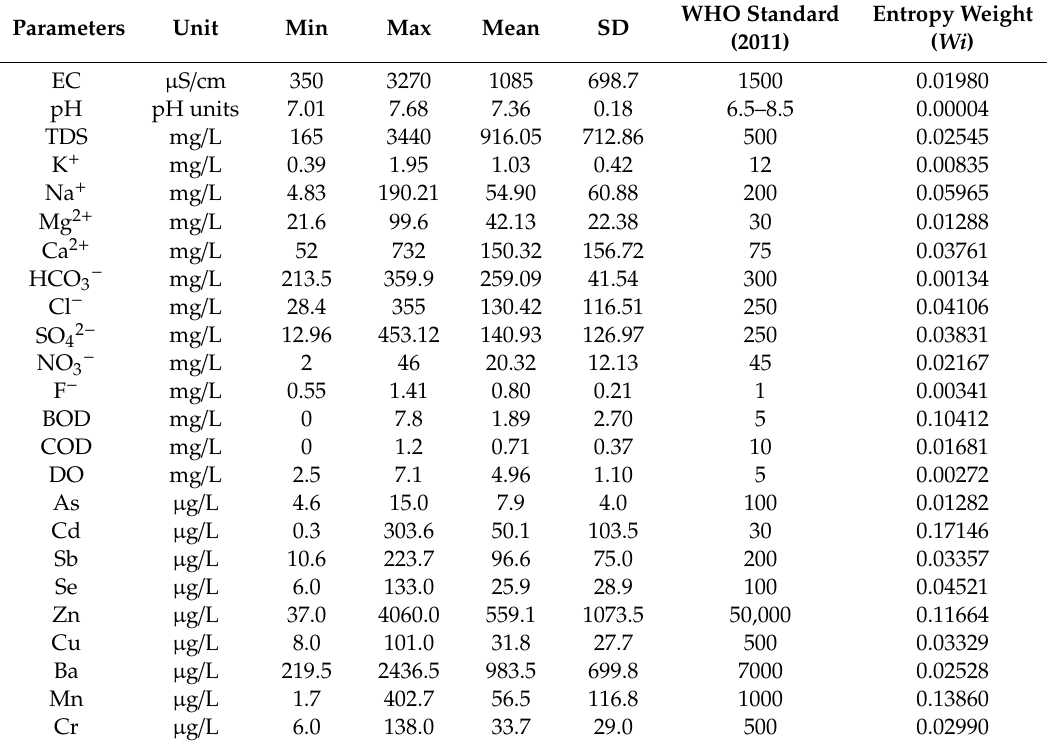
Table 3. Descriptive statistics of chemical content in the groundwater